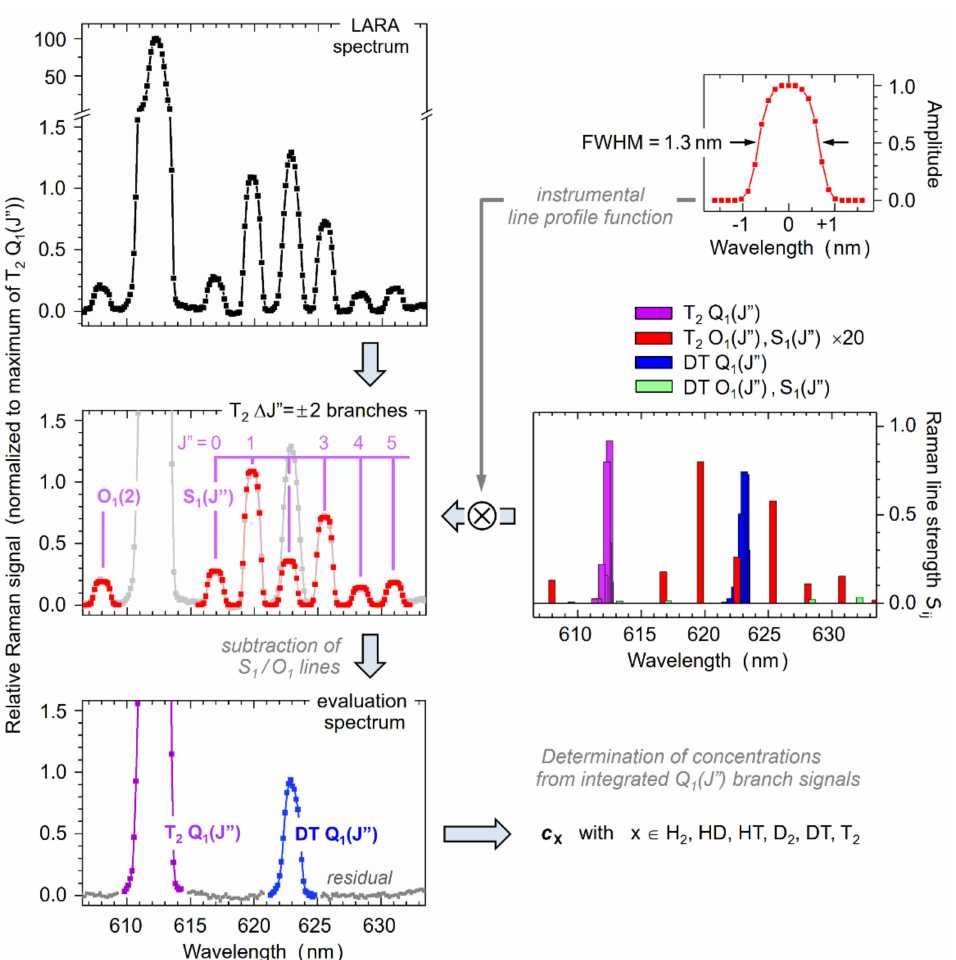
Figure 5. Deconvolution of spectral overlapping, exemplified for the determination of exact T 2 / DT concentrations in the KNM1 gas mixture. Top-left—segment of the spectrum in Figure 3c (the scale is split, to visualize all spectral features; center-left—theoretical O 1 ( J ”) / S 1 ( J ”) lines for T 2 , overlaid on the experimental spectrum, with the individual Raman lines annotated; bottom-left—spectrum with the O 1 ( J ”) / S 1 ( J ”) lines subtracted, leaving only the Q 1 (J”)-branches to evaluate species concentrations. Top-right—experimental line profile function, derived using ShapeFit ; center-right—theoretical Raman line strengths ϕ ij for the O 1 ( J ”) / Q 1 ( J ”) / S 1 ( J ”) lines of T 2 and DT, calculated for a gas temperature of T = 298 ± 2 K. Note that the values for the O 1 ( J ”) / S 1 ( J ”) lines of T 2 are scaled by × 20, to emphasize the overlap between T 2 S 1 (2) and DT Q 1 ( J